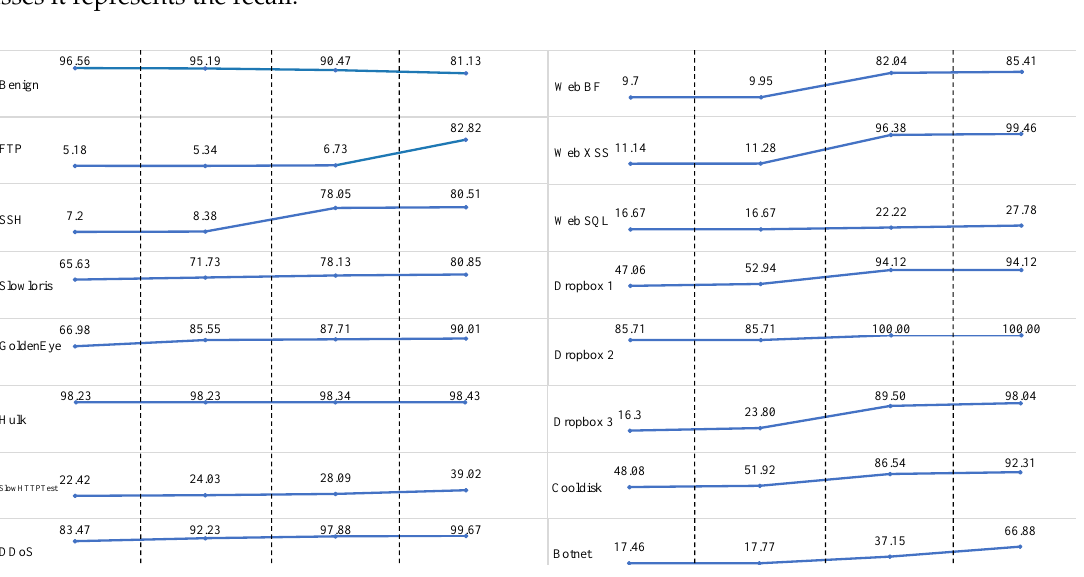
Figure 3. CICIDS2017 Autoencoder Detection Results Summary Per